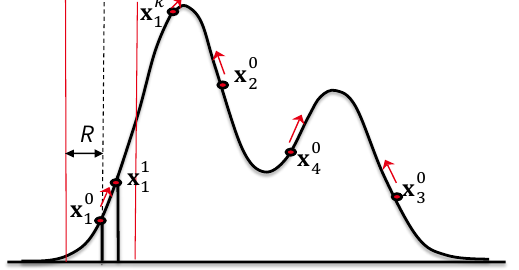
Fig. 2. Iterative procedure for simultaneous search of centers of several classes